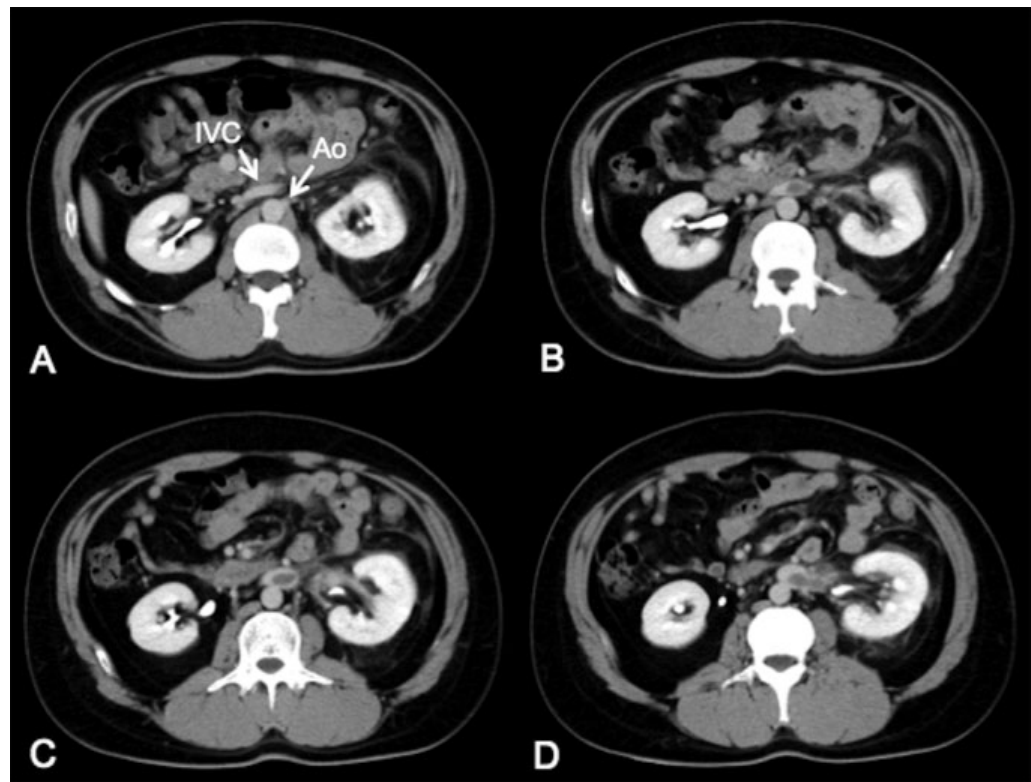
Fig. 1 ( A – D ) Axial view of contrast-enhanced computed tomography from cranial to caudal. Left inferior vena cava (IVC) crosses over the abdominal aorta, and IVC thrombus is shown.